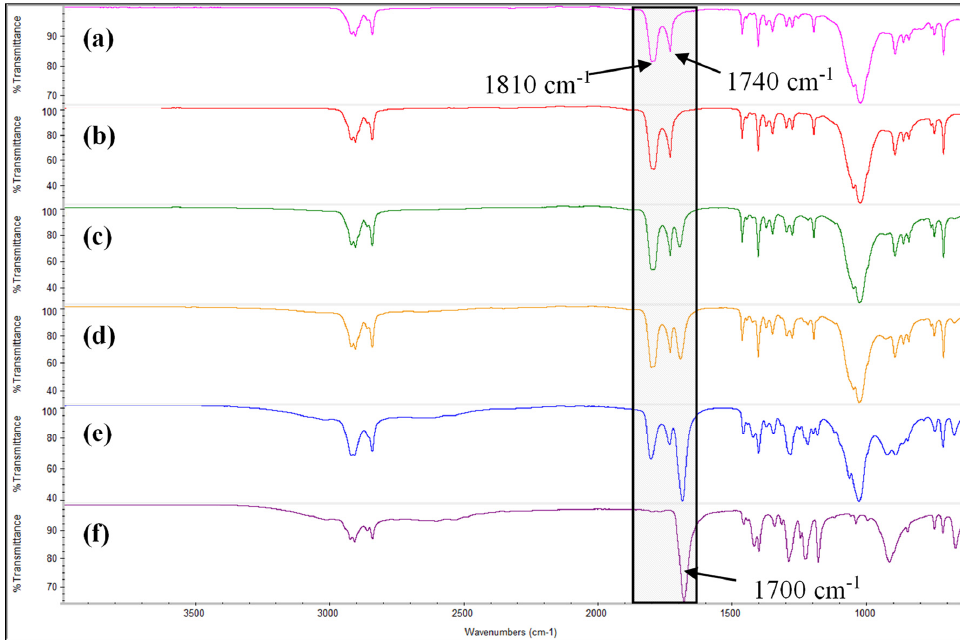
Figure 1. FT − IR spectra of poly(sebacic acid) synthesized using ( a ) 5 equiv. ( b ) 1 equiv. ( c ) 0.75 equiv. ( d ) 0.5 equiv. and ( e ) 0.25 equiv. of acetic anhydride; ( f ) sebacic acid. Polyanhydrides synthesized in triplicate at 160 °C under vacuum (~10 m bar) for 4 h.